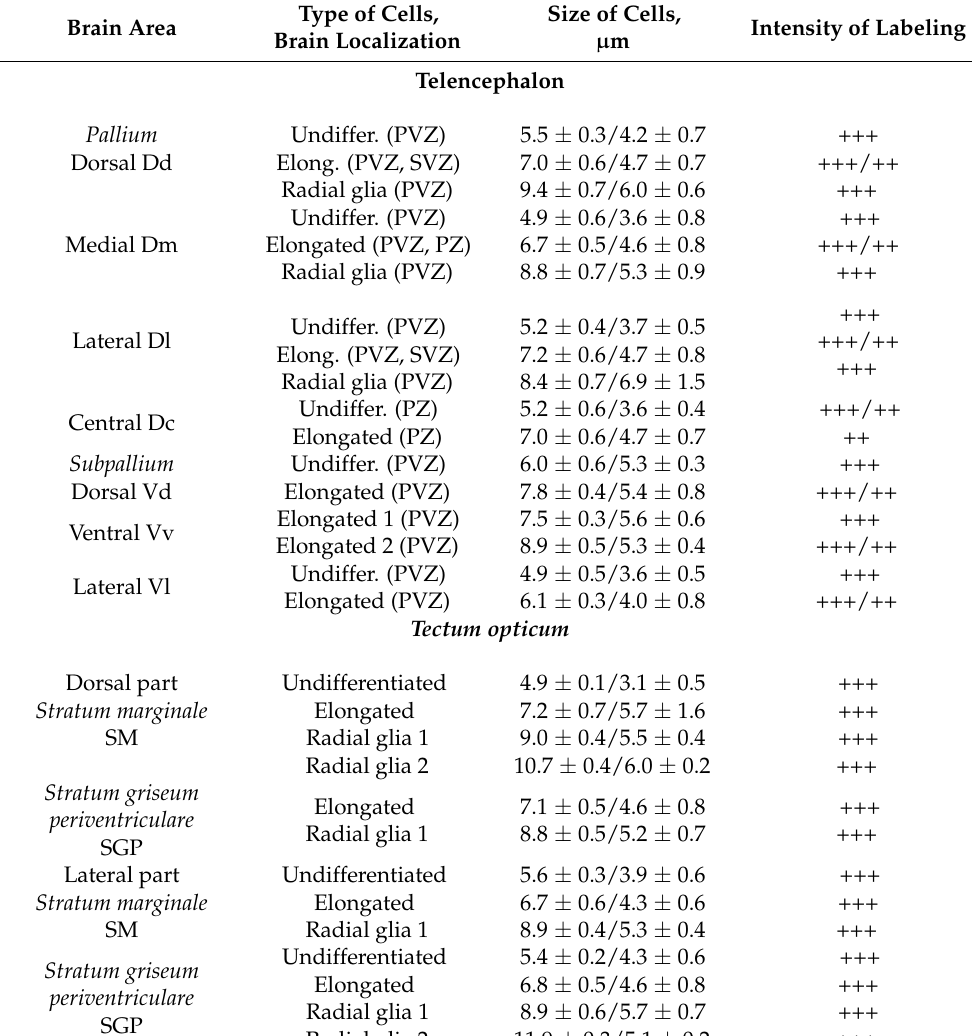
Table 1. Morphometric and densitometric parameters (M ± SD) of glutamine-synthetase- immunopositive cells in the telencephalon and optic tectum of trout, Oncorhynchus mykiss . Type of Brain Area